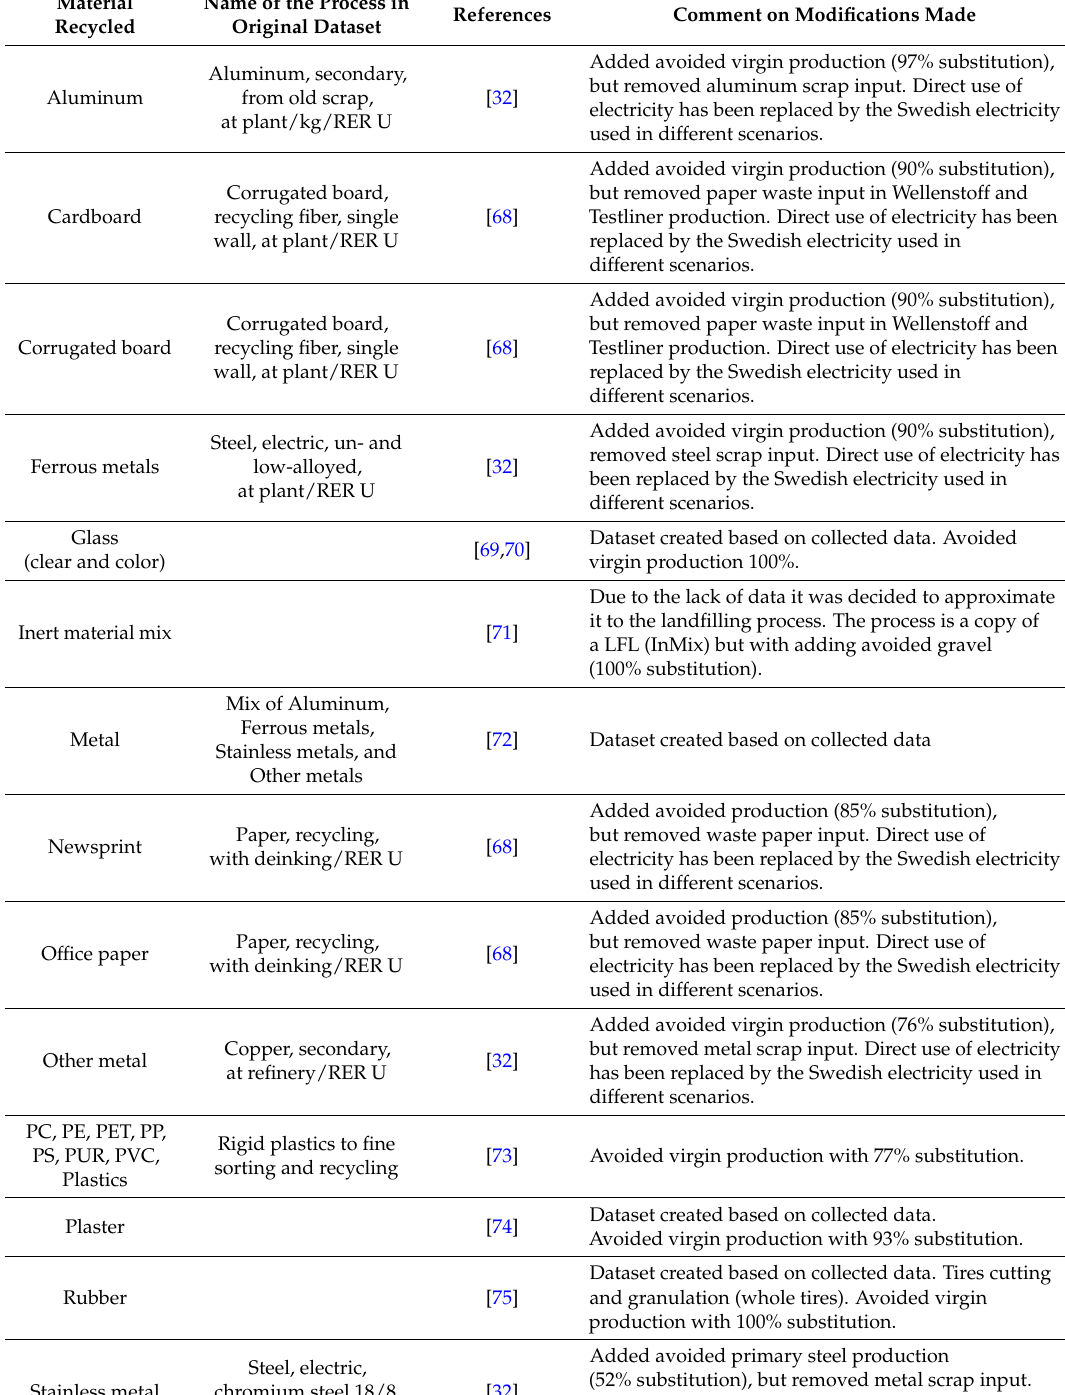
Table A2. Process data for